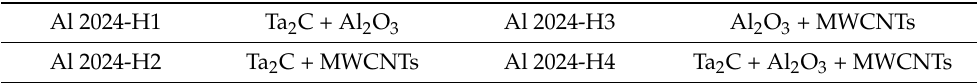
Table 3. The combination of the reinforcement particles into the Al 2024 aluminum alloy matrix.